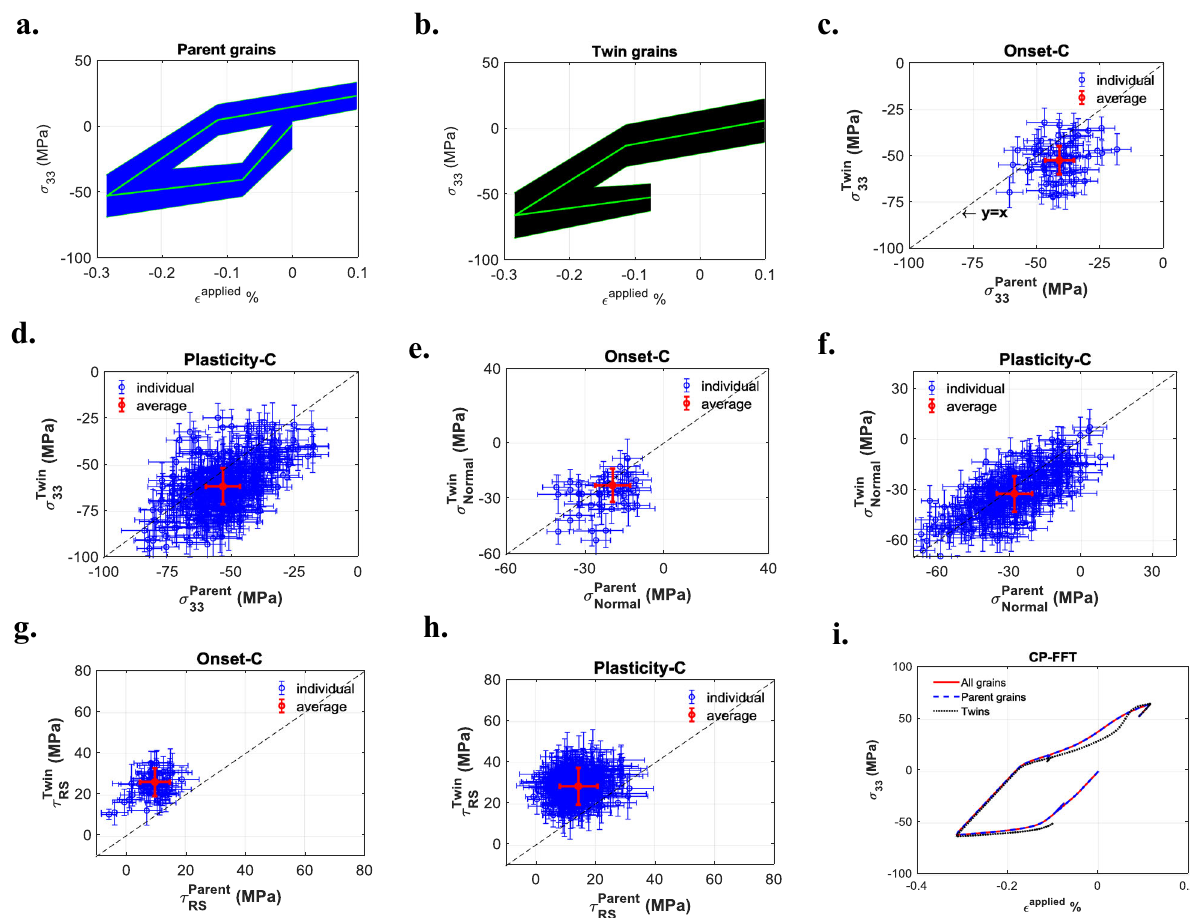
Fig. 2 Formation of twins. The measured σ 33 in ( a ) parent grains and ( b ) twins. The shaded region represents the full width at half maximum (FWHM) of σ σ σ 33 distribution. The measured 33 in twins as a function of the measured 33 in the corresponding parents for ( c ) Onset-C and ( d ) Plasticity-C steps. Measured stress normal to the twin habit plane at ( e ) Onset-C and ( f ) Plasticity-C steps. Measured resolved shear stress on the twin habit plane in the twinning direction at ( g ) Onset-C and ( h ) Plasticity-C steps. ( i ) The simulated stress – strain curves of twins and parents from CP-FFT. The dotted lines in ( c ) – ( h ) are for clarity and to show when the parameter of the vertical axis becomes equal to that of the horizontal axis and the circles with their crosses represent the stress values and their corresponding error